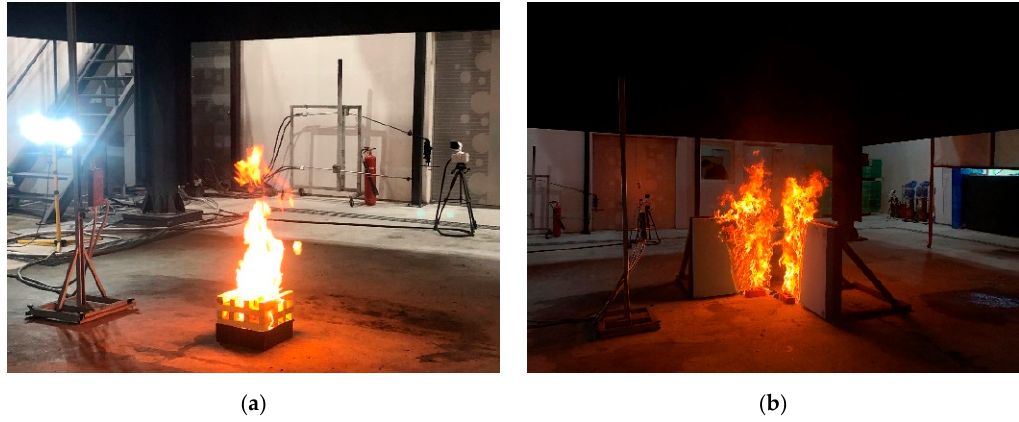
Figure 2. Independent measurement of heat release rate for ( a ) the wood crib and ( b ) polyether foam. The experimental results of HRR in the free burn and ceiling temperature in the compartment fire equipped with a sprinkler are shown in Figure 3.